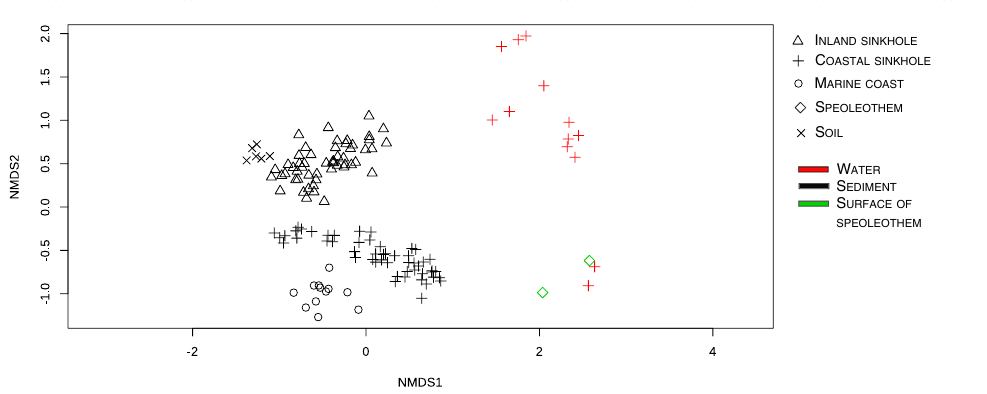
Figure 5. Beta diversity analysis of microbial communities from sediment, water and surface of speleothems from studies performed in the Yucatan peninsula (normalization of 3490 reads by